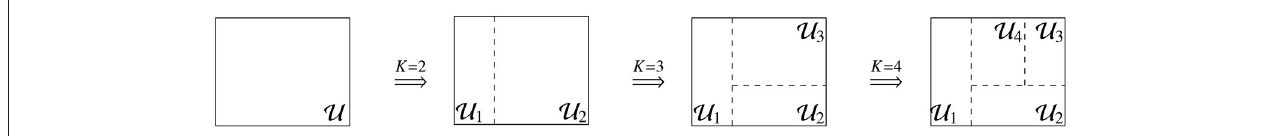
FIGURE 4 | Sketch of proposed partitioning algorithm.